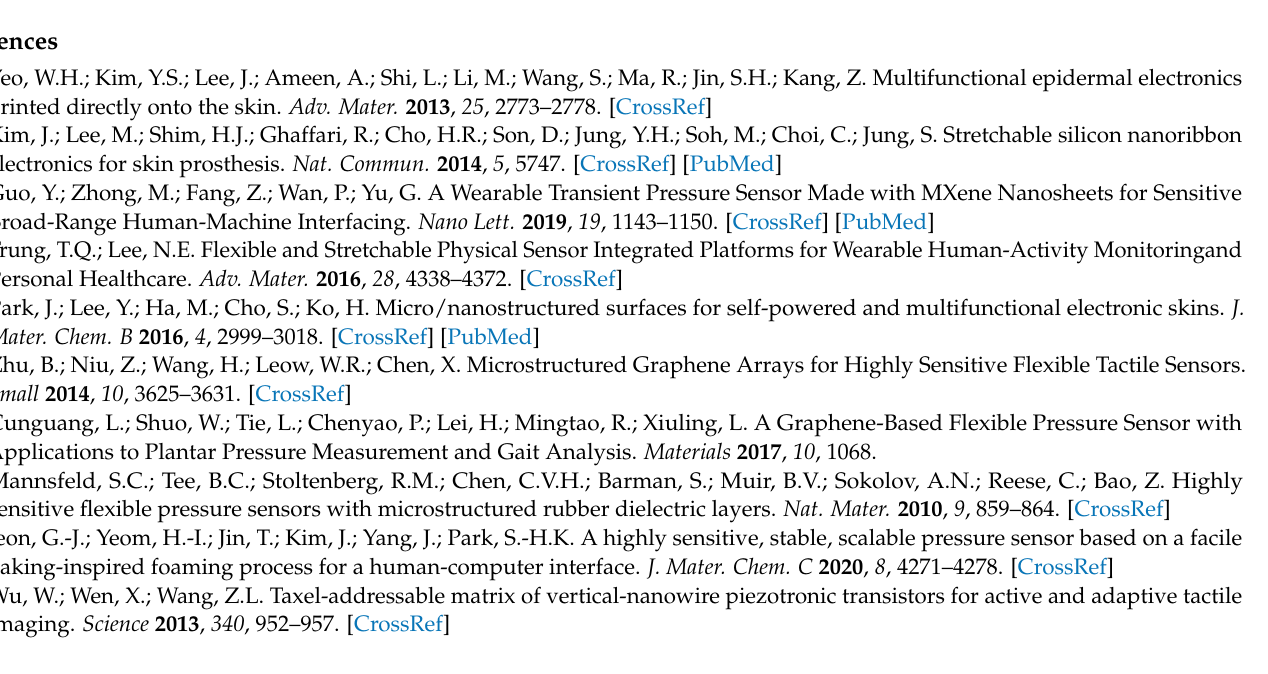
Figure S2: Nominal stress vs. strain curve of the silicone rubber sheet